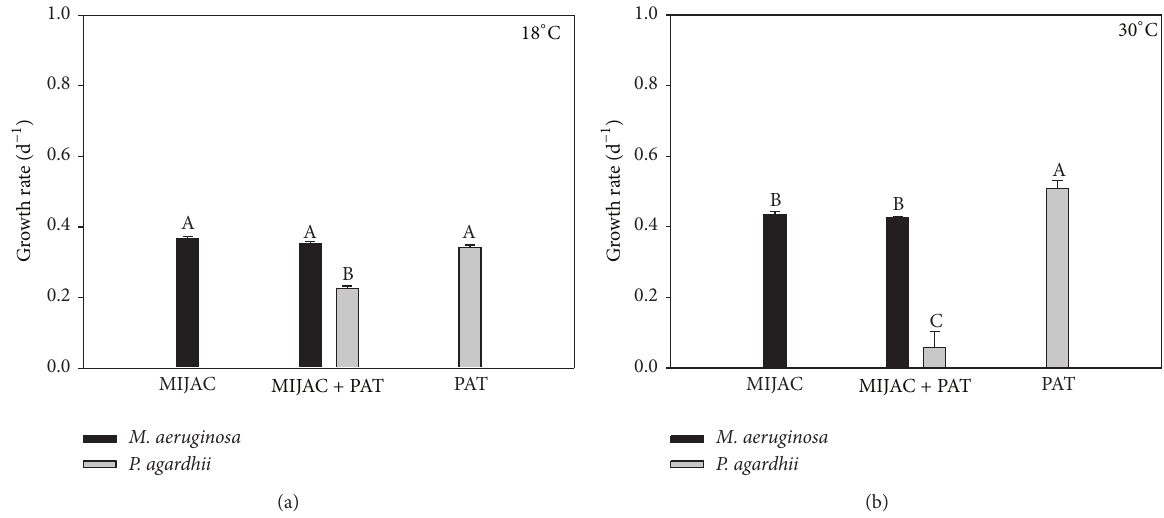
Figure 3: Chlorophyll- a -based growth rate of monocultures and mixed cultures of M. aeruginosa (MIJAC) and P. agardhii (PAT) at two different temperatures (18 ∘ C and 30 ∘ C). Different letters represent significant differences at 𝑝 < 0.05 .